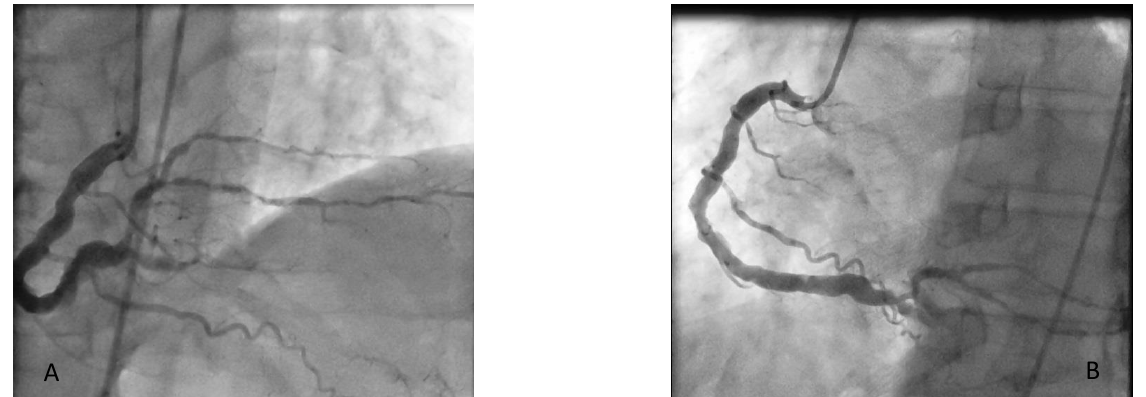
Figure 3. (A, B). Two image of Right coronary angiogram showing diffuse ectasia of the right coronary artery